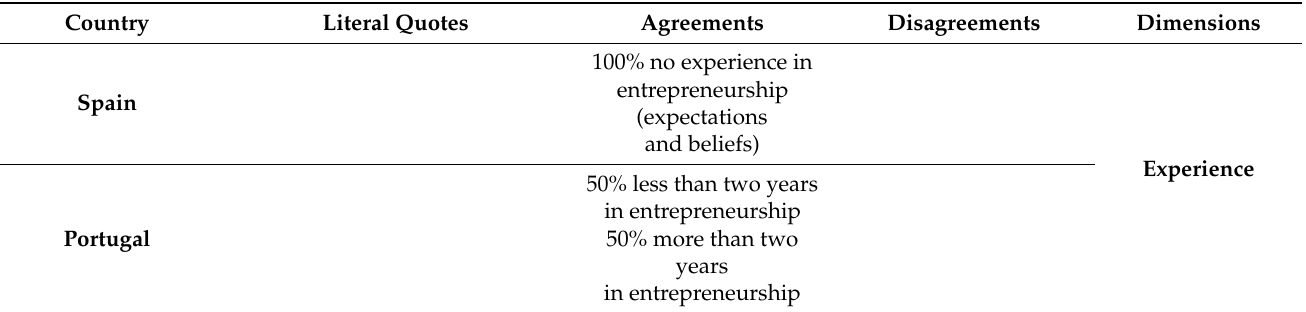
Table A2. Results of FGs organized concerning the studied